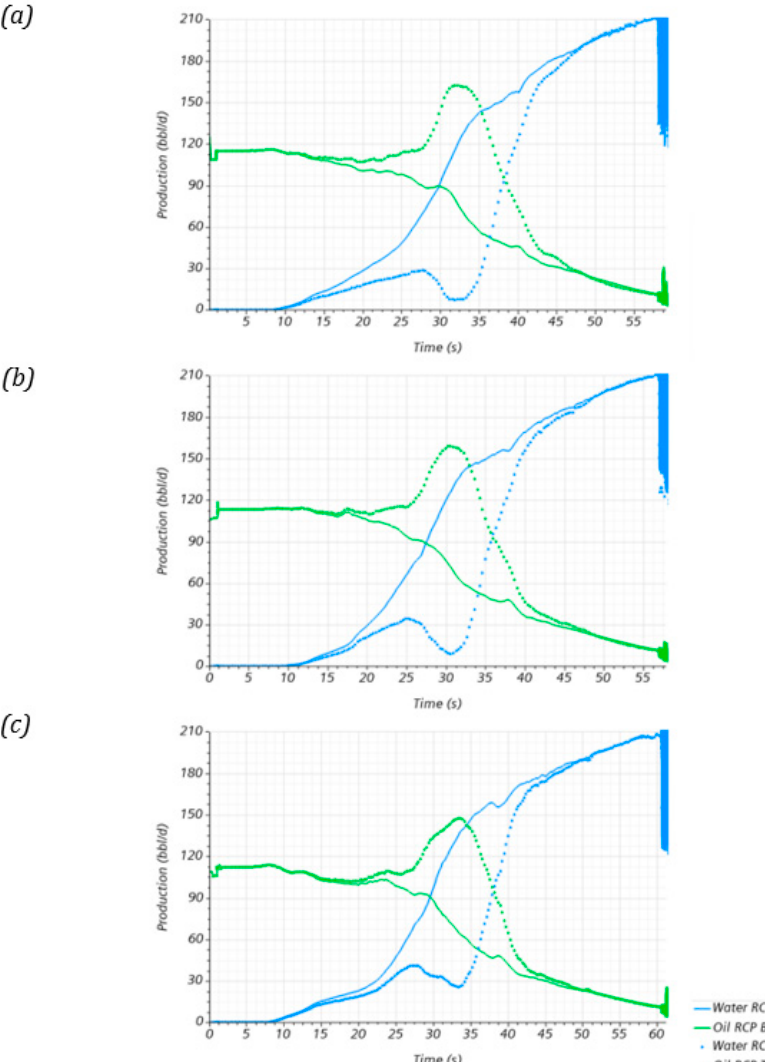
Figure 13. Production profiles obtained for the two RCP valves for the oil density sensitivity analysis: